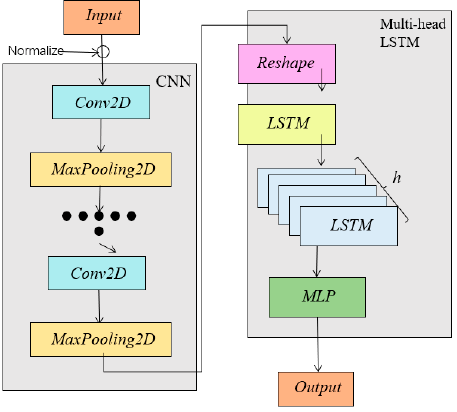
Figure 1. Structure of the CMLA model.